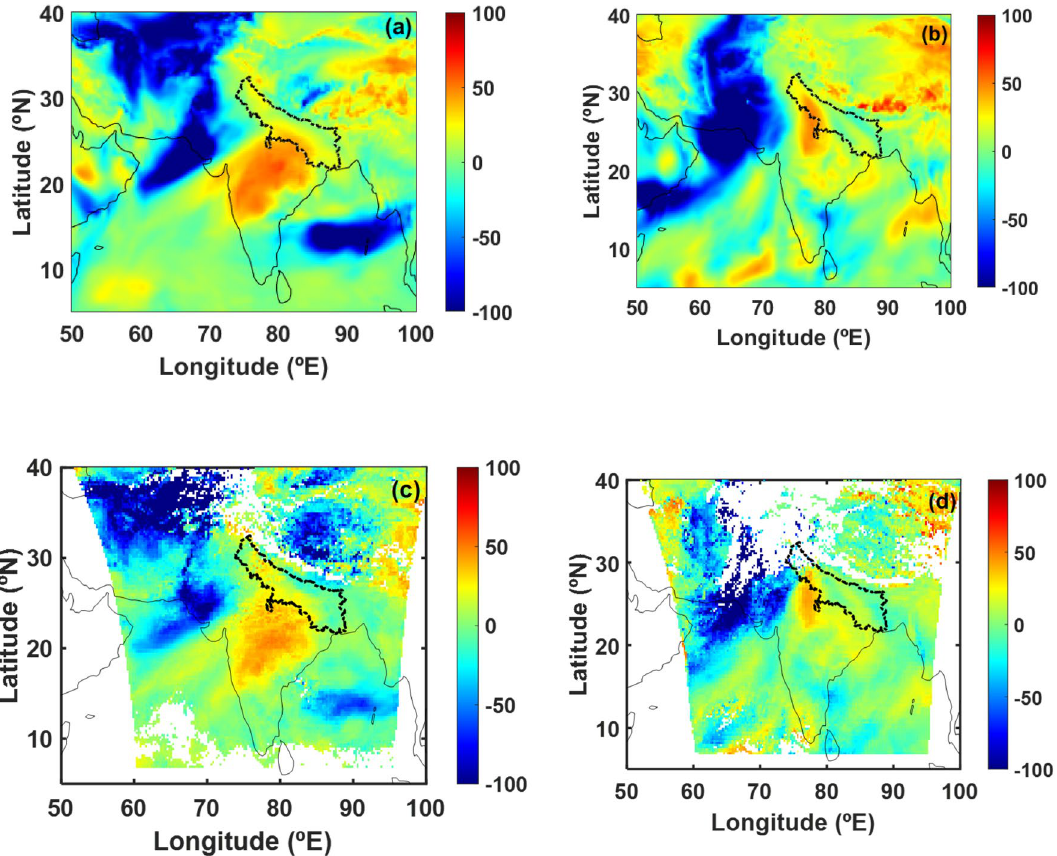
Figure 3. Fractional contribution of AR to the water vapor amount over IGP region. Contribution of AR to the integrated water vapor (IWV) using reanalysis data over IGP on ( a ) Dec 10, 2015 and ( b ) Jan 13, 2020. Contribution of AR to precipitable water vapor (PWV) using satellite data over IGP on ( c ) Dec 10, 2015 and ( d ) Jan 13, 2020. Black dashed line in the figure represents the IGP region. White color in figures ( c ) and ( d ) indicate non-availability of data. Figure is generated using MATLAB R2020a software available at http:// in. mathw orks. com/ produ cts/ matlab/. (License no: 1103382).